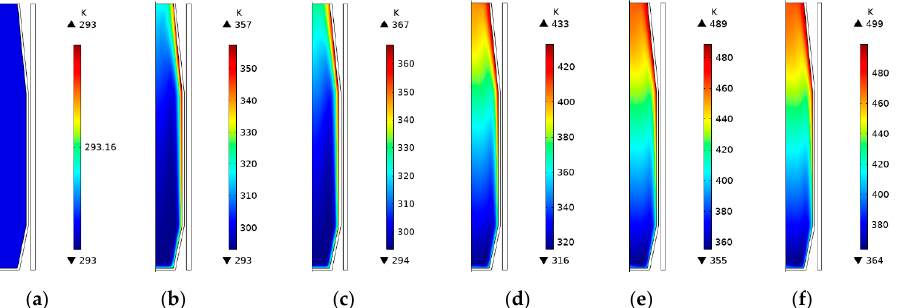
Figure 7. Temperature distribution of the explosive. ( a ) 0min. ( b ) 8min. ( c ) 10min. ( d ) 30min. ( e ) 50min. ( f ) 52min.